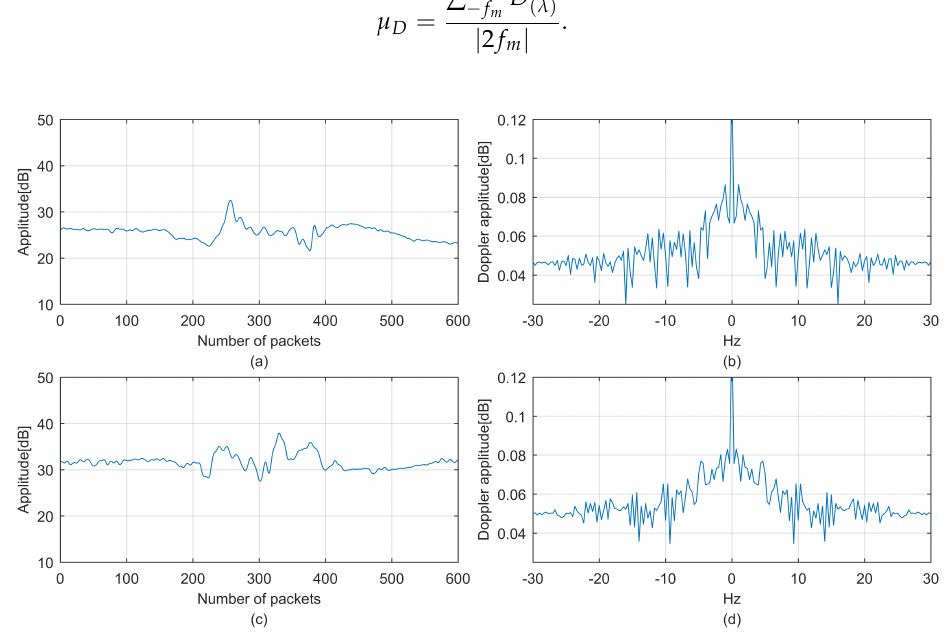
Figure 7. CSI profiles: ( a ) walking time profile; ( b ) walking Doppler frequency profile; ( c ) running time profile; ( d ) running Doppler frequency